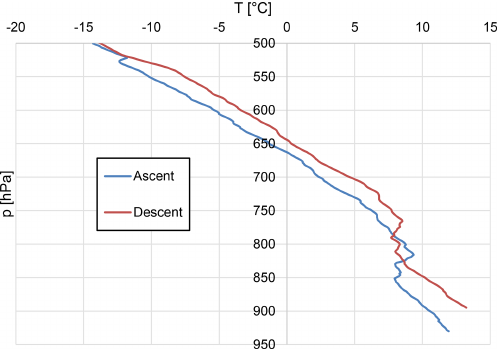
Figure 20. Shift of the tropospheric profile as a function of pressure: profile from 23 September 2019, 12:00UTC, Praha-Libus.